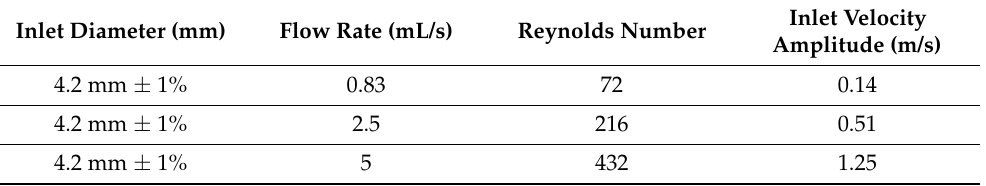
Table 1. Table of flow conditions.